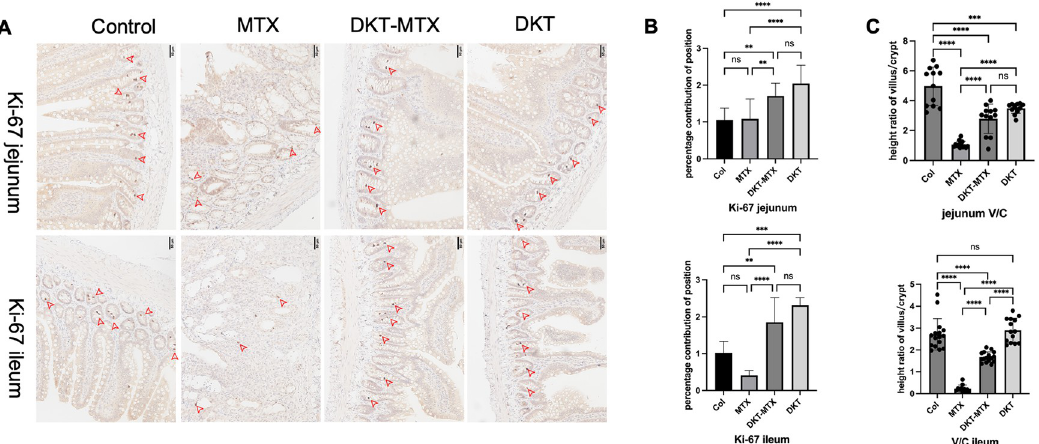
Fig 3. DKT enhanced the small intestinal crypt cell proliferation after the administration of MTX. (A) Immunohistochemical results showed that the small intestinal mucosal crypts in the DKT-MTX group contained more Ki-67-positive cells than the MTX group. (B) The DKT-MTX group had a higher percentage contribution of Ki-67 positivity than the MTX group. Scale bar = 50 μ m. For each criterion, the percentage contribution of Ki-67 positivity was calculated for at least 10 positions using image J software.